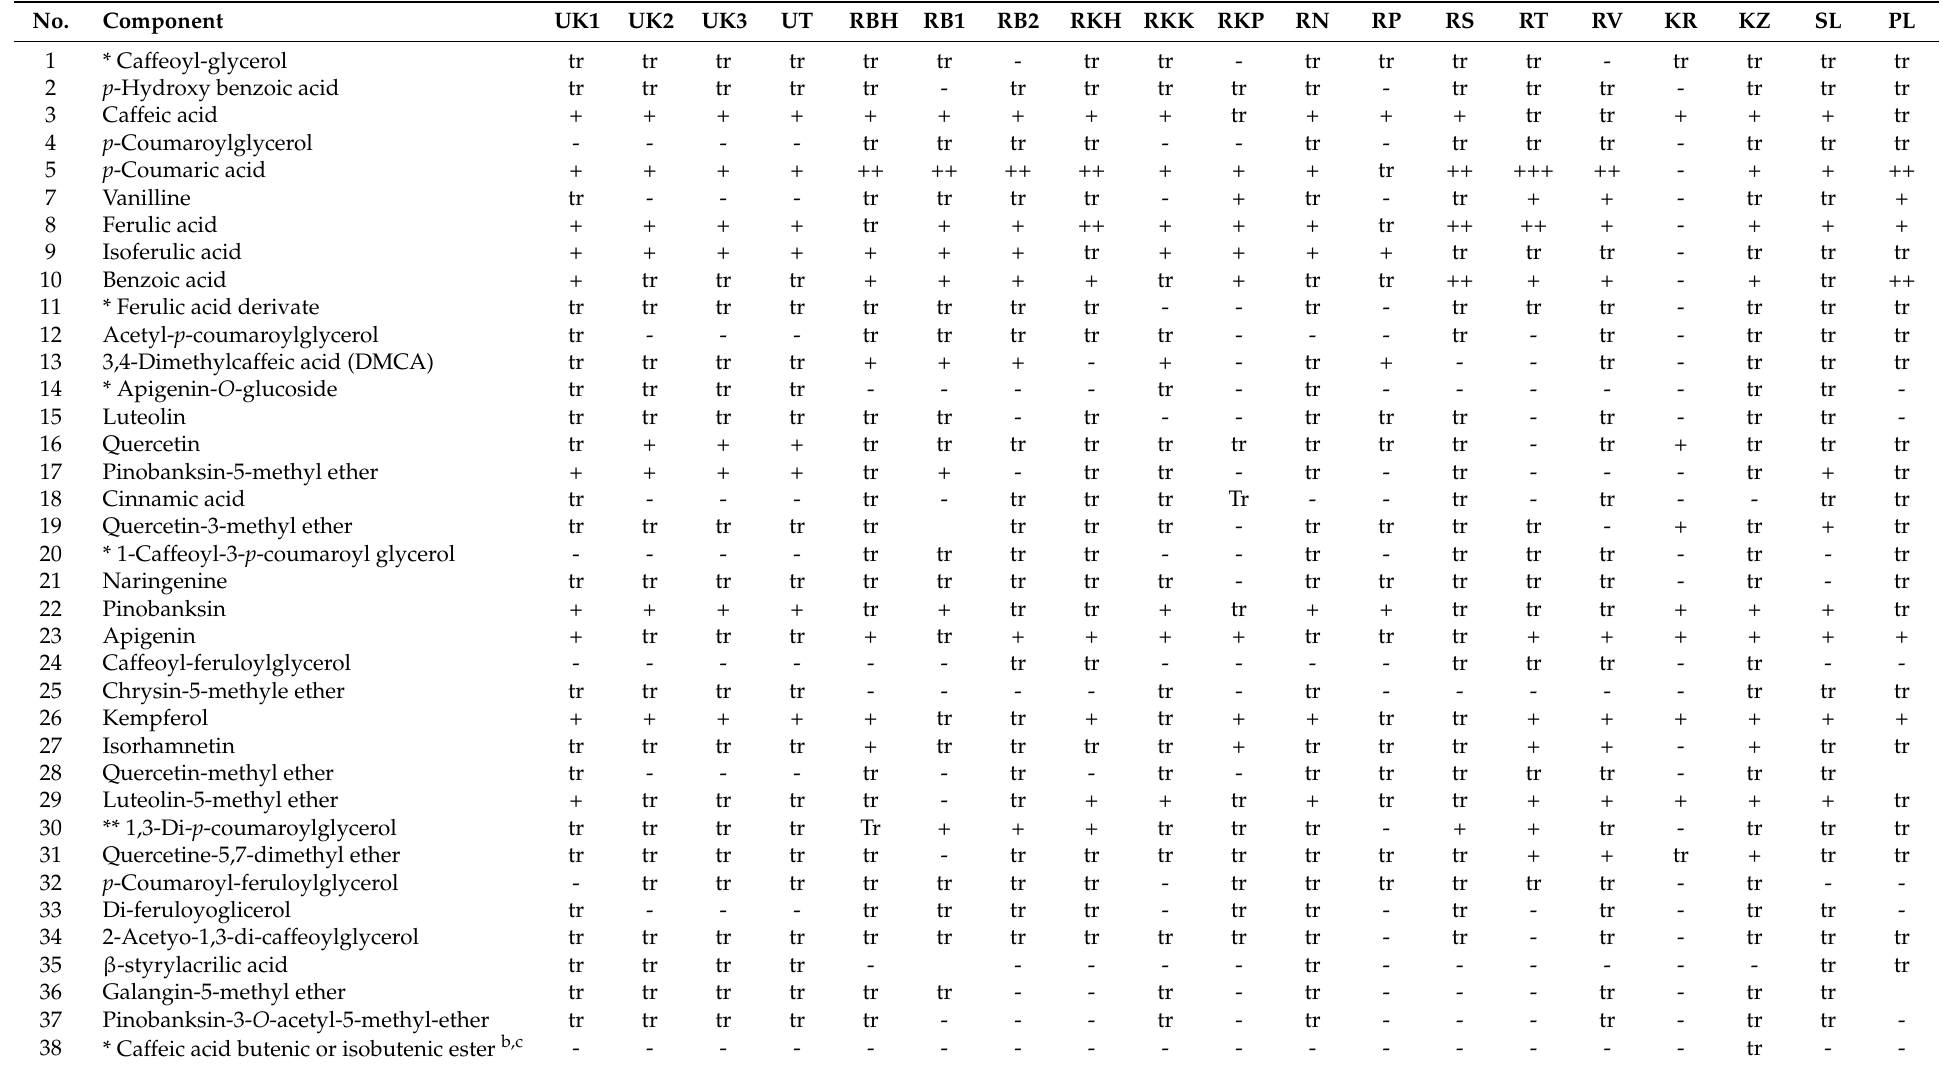
Table 2. Relatively concentration of components in UPLC-DAD